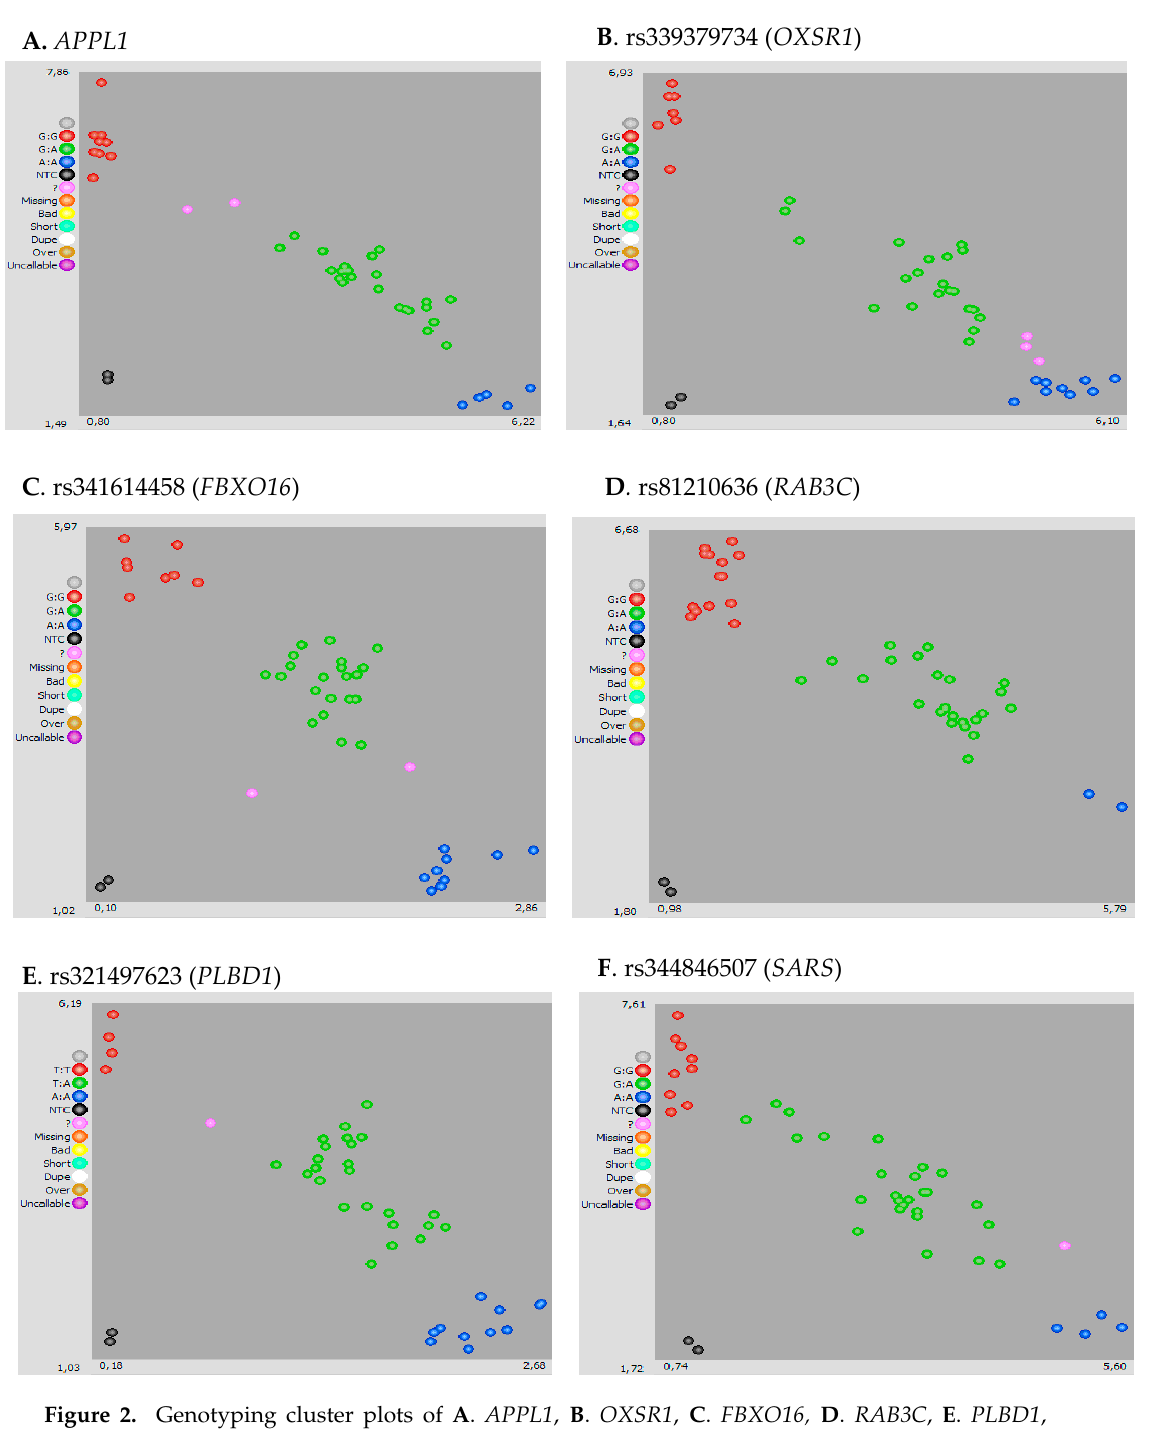
Figure 2. Genotyping cluster plots of A . APPL1 , B . OXSR1 , C . FBXO16, D . RAB3C , E . PLBD1, and F . SARS genes using the Kompetitive Allele Specific PCR (KASP) assay. Samples shown in pink were considered questionable genotypes as they were not assigned to the cluster. NTC, non-template control. Visualization of the genotype data was performed with the SNPViewer software (http://results.lgcgenomics.com/software/snpviewer).